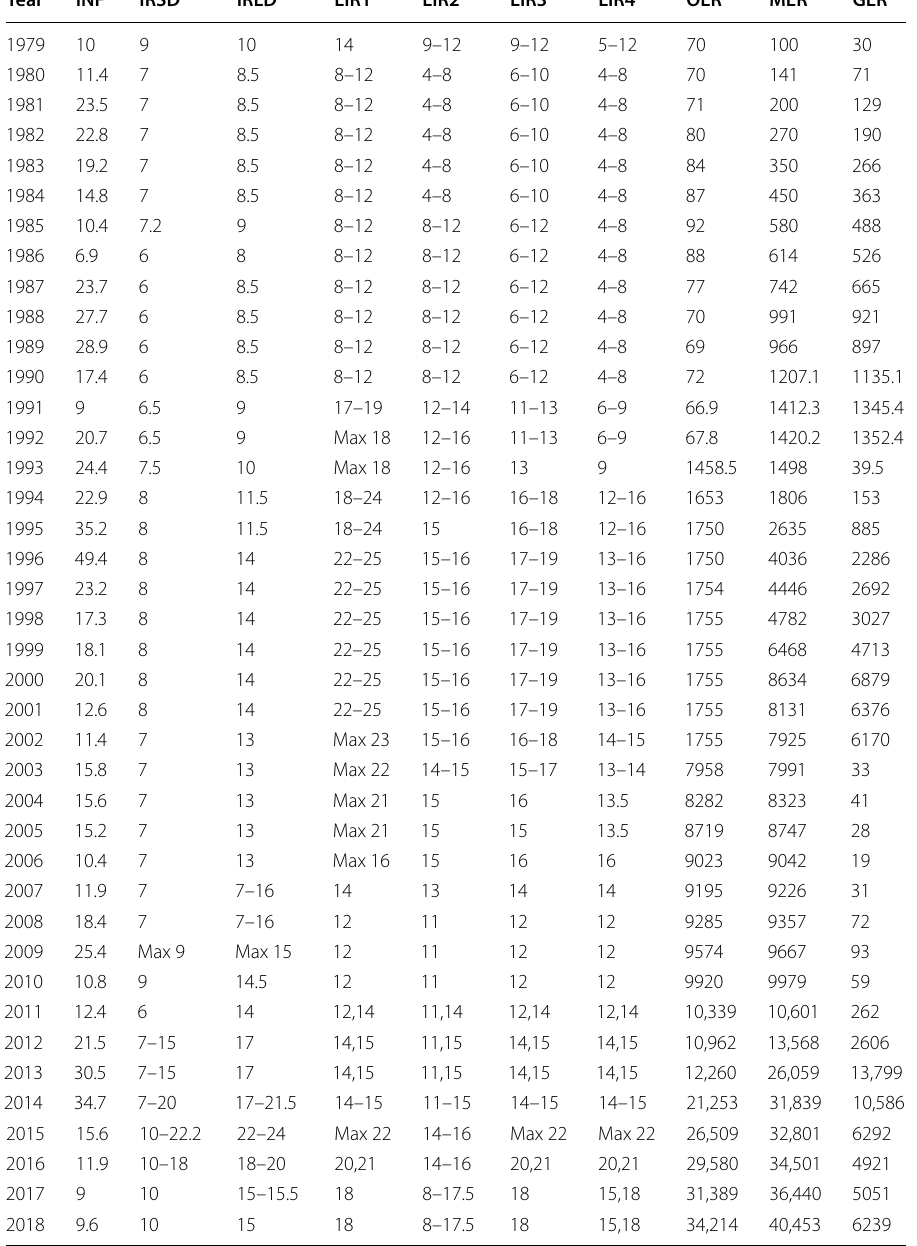
Table 1 The inflation rate, the interest rate of bank deposits and loans, exchange rates in (1979–